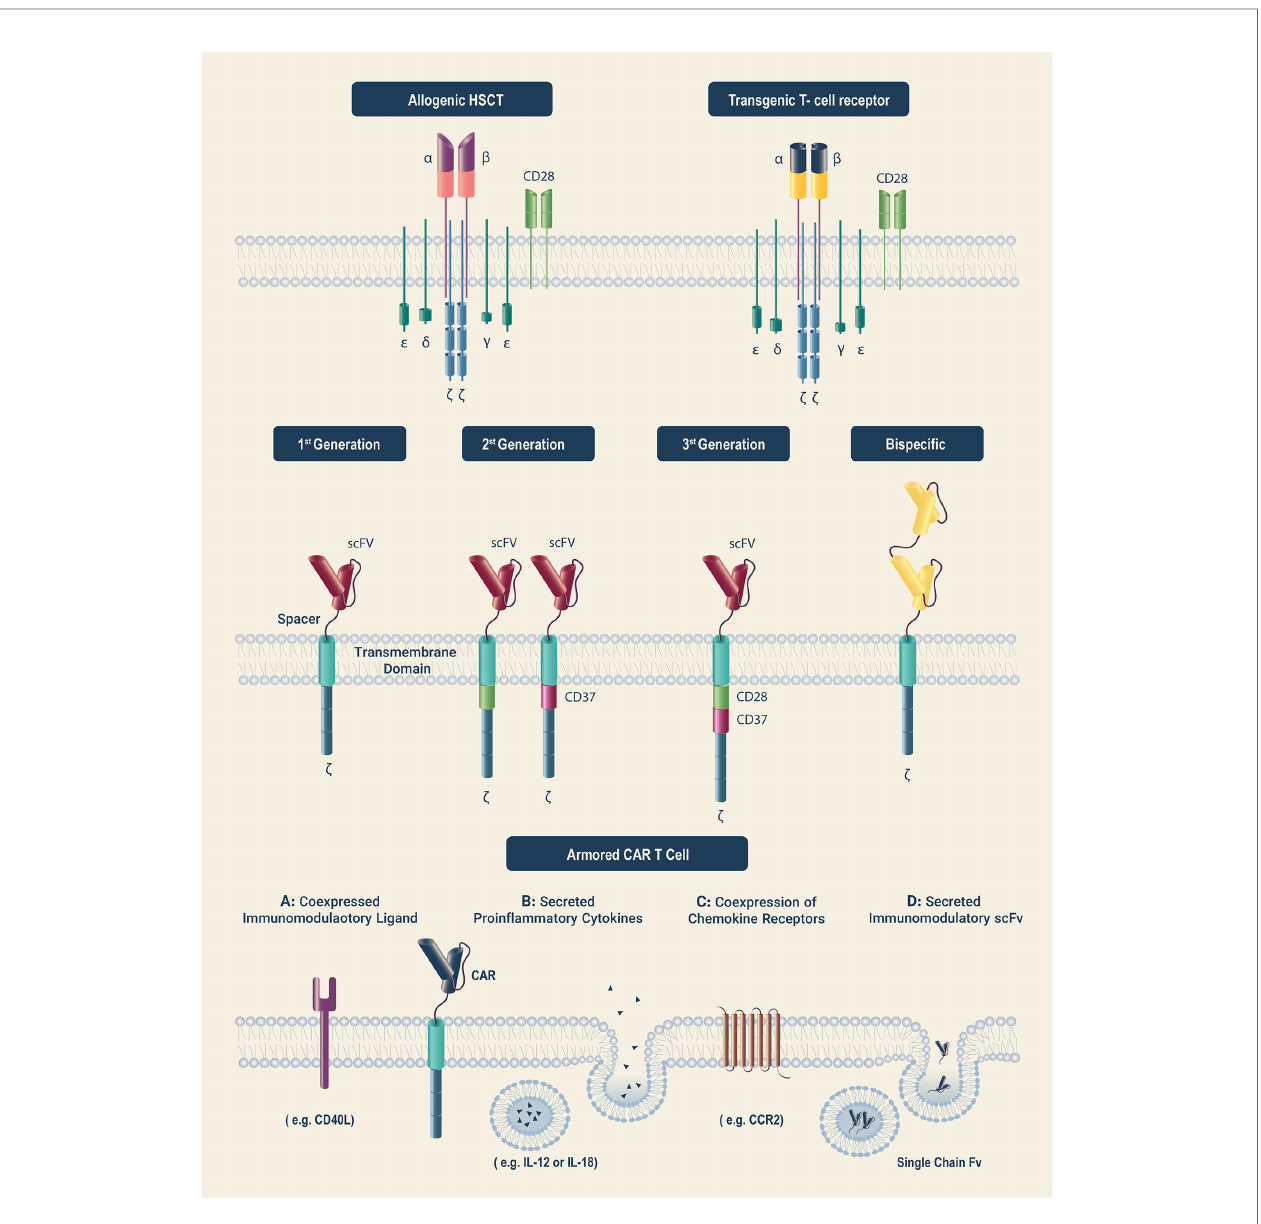
FIGURE 2 | Generations of CAR-T cells along with allogenic, transgenic, bispeci fi c, and armored CAR-T cells. In the upper quadrant, allogeneic and transgenic CAR-T cells are seen. Allogeneic CAR-T cells are seen in patients that have allogeneic HSCT and can be either donor- or recipient-derived. On the other hand, transgenic CAR-T cells are engineered CAR-T cells that have been made by transfection of a special gene to encode the surface receptor of CAR-T cells. In the middle quadrant, three generations of CAR-T cells are shown. Besides, bispeci fi c CAR-T cells are engineered to target two different targets simultaneously. In the lower quadrant, armored CAR-T cells which have been potentiated by secreting cytokines and chemokines are seen. HSCT, hematopoietic stem-cell transplantation; CCR2, chemokine receptor